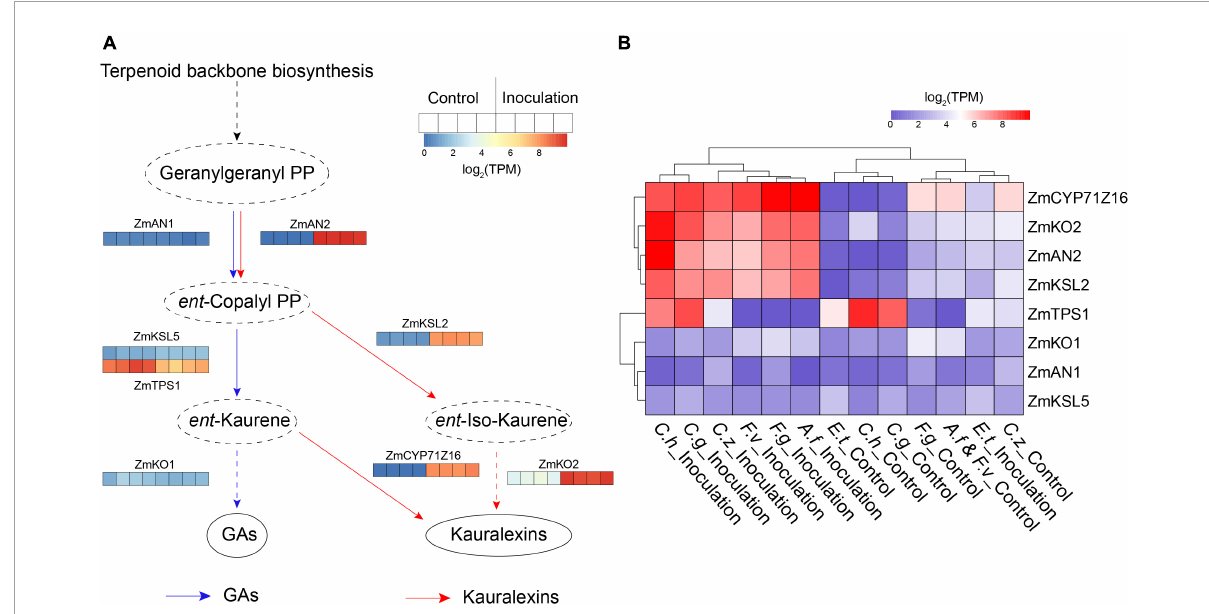
FIGURE4 Expression patterns of kauralexin and gibberellic acid (GA) biosynthesis related genes. (A) Heat map of expression of kauralexin and GA biosynthesis related genes after inoculation with Cochliobolus heterostrophus . For each gene, the transcripts per million (TPM) value of four biological replicates is shown. (B) Heat map of expression of kauralexin and GA biosynthesis related genes after inoculation with all the seven independent pathogens. For each gene, average log2 TPM of each treatment is